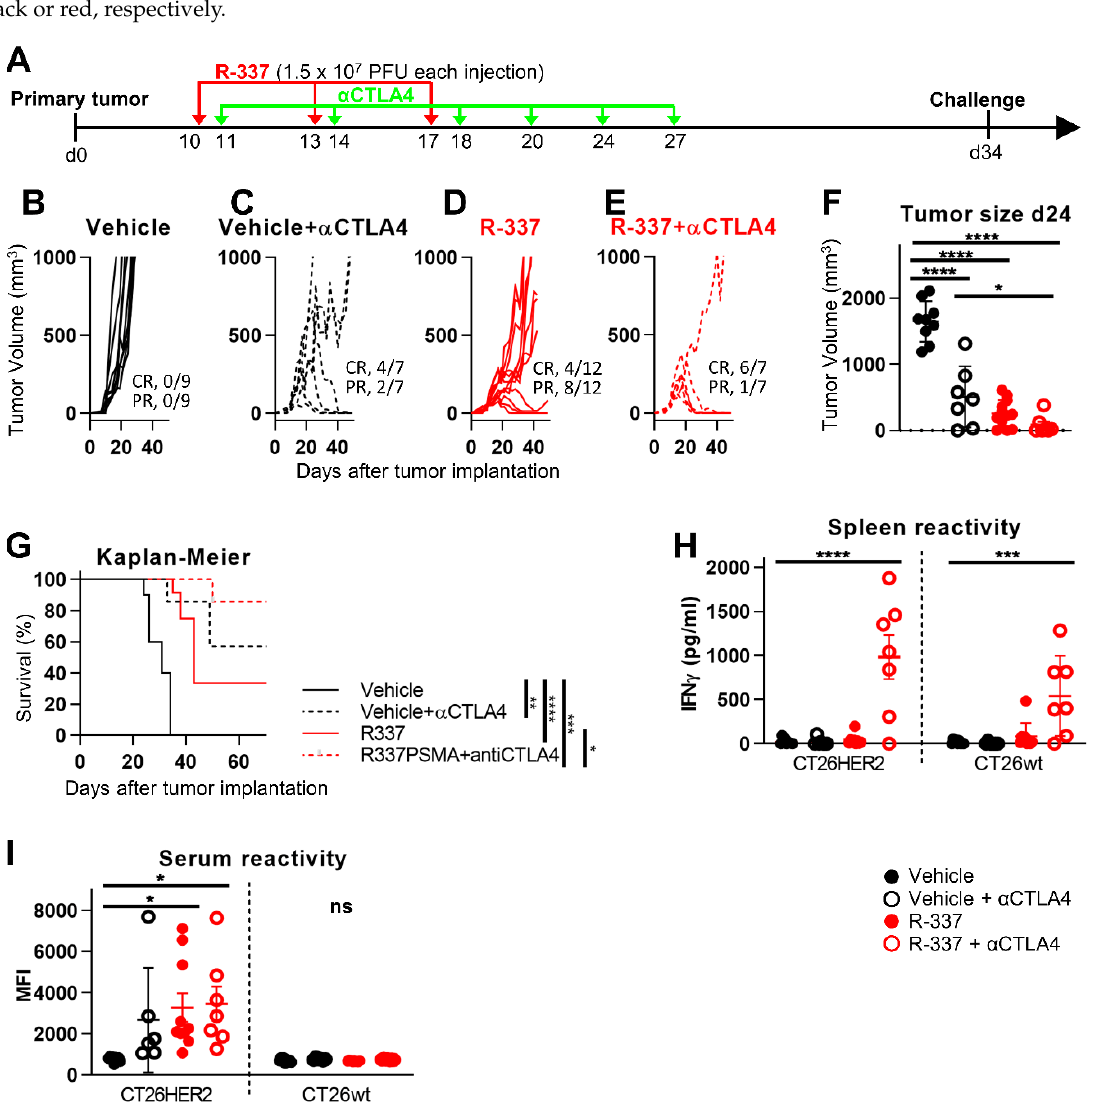
Figure 5. Efficacy of R-337 in combination with anti-CTLA-4 antibodies on the growth of CT26-HER2 tumors. ( A ) Schedule of the treatments. The HER2-TG BALB/c mice were implanted with CT26-HER2 cells. At d 10 after implantation, when tumors reached the average volume of 70–100 mm 3 , mice received 3 i.t. injections of R-337 plus i.p. injections of anti-CTLA- 4 (abbreviated as αCTLA4), at intervals of 2– 4 days. The administration schedule of R-337 and CPI treatments was accord- ing to Figure 3 and [25]. ( B – E ) Kinetics of tumor growth in mice treated with vehicle ( B ), vehicle plus αCTLA4 ( C ), R-337 alone ( D ), or R- 337 plus αCTLA4 combination therapy ( E ). Numbers in panels indicate the number of mice exhibiting complete response (CR) or partial response (PR). ( F ) Volumes of the primary tumors at d 24 after implantation. ( G ) Kaplan – Meier survival curves of the four groups of mice. ( H , I ) Immune response in splenocytes and sera to CT26-HER2 and CT26- wt cells was measured as detailed in legend to Figure 1. H, I. Statistical significance was calculated by the ANOVA test ( F , H , I ) or the Log-rank (Mantel-Cox) test ( G ) and expressed as * = p value < 0.05; ** = p value < 0.01; *** = p value < 0.001; **** = p value < 0.0001; ns = non-significant. Color codes: mice treated with vehicle or R-337 are indicated in black or red, respectively. Full circles and continuous lines, monotherapies. Open circles and dotted lines, combination therapies. 4. Discussion The objective of this study was two-fold; to evaluate the efficacy and the global im- mune response elicited by the HER2-retargeted oHSV R-337 against the CT26-HER2 tu- mor and to obtain an insight into the basis of immune protection. CT26 tumor is consid- ered the prototype of immunologically hot murine tumors [27,31,36]. CT26-HER2 tumors were implanted in ad hoc generated HER2-transgenic/tolerant BALB/c mice. Previously, we reported on the immunotherapy exerted by the same virus on the immunologically cold LLC1-HER2 tumor implanted in HER2-transgenic C57BL/6 mice [25].